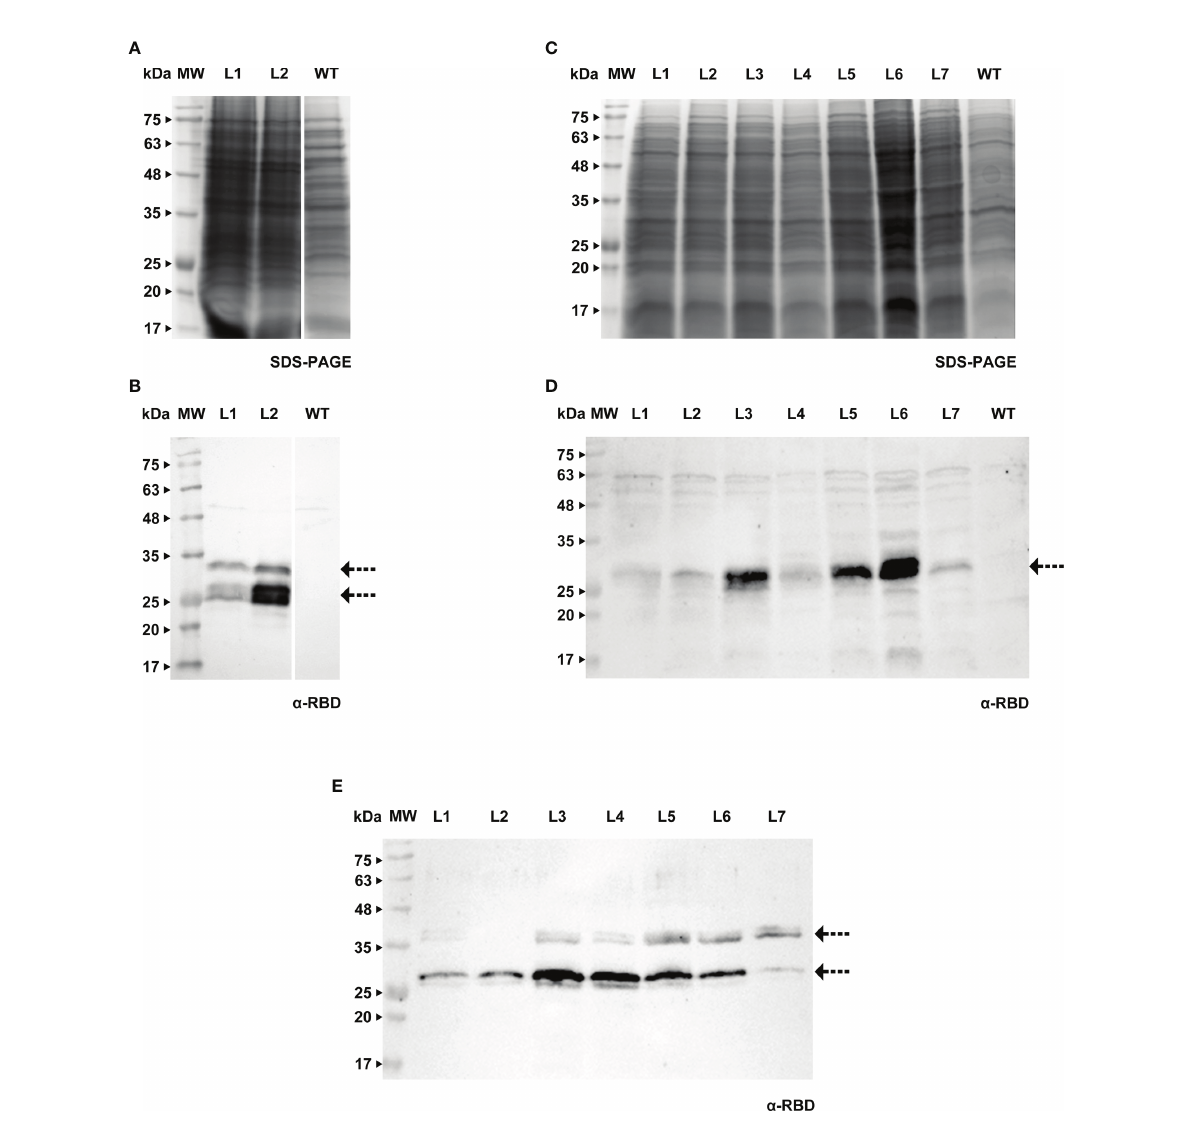
FIGURE 3 Detection of RBD in calli (A, B) , cell extracts (C, D) and spent medium (E) of BY-2. (A) Stained gel containing total protein extract of two calli of BY-2, WT - wild type. (B) Corresponding WB with anti-RBD antibody. (C) Stained gel containing cellular extract of seven independent BY-2 cell lines, WT - wild type. (D) Corresponding WB with anti-RBD antibody. (E) WB analysis of the spent medium of seven independent BY-2 cell lines with anti-RBD